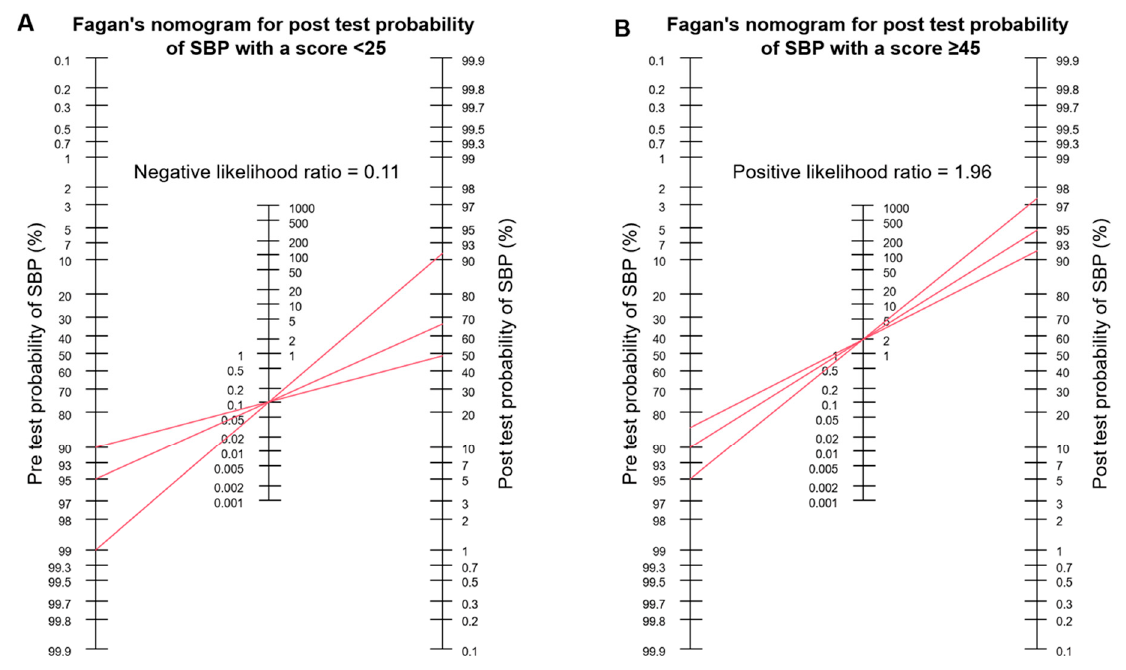
Figure 4. Fagan’s nomograms for post-test probability. ( A ) Post-test probability of SBP for a point- score model < 25. Referring to a pre-test probability of 95%, 90%, and 85% for SBP (corresponding to a prevalence of 5%, 10%, and 15% for SecP), of all cases with infected ascites, a score < 25 leads to a post-test probability of 66.7%, 48.6%, and 37.4%, respectively. ( B ) Post-test probability of SBP for a point-score model ≥ 45. Assuming a pre-test probability for SBP of 95%, 90%, and 85% by referring to all cases with infected ascites (corresponding to a prevalence of 5%, 10%, and 15% for SecP), a score ≥ 45 results in a positive predictive value of 97.4%, 94.6%, and 91.7%, respectively.